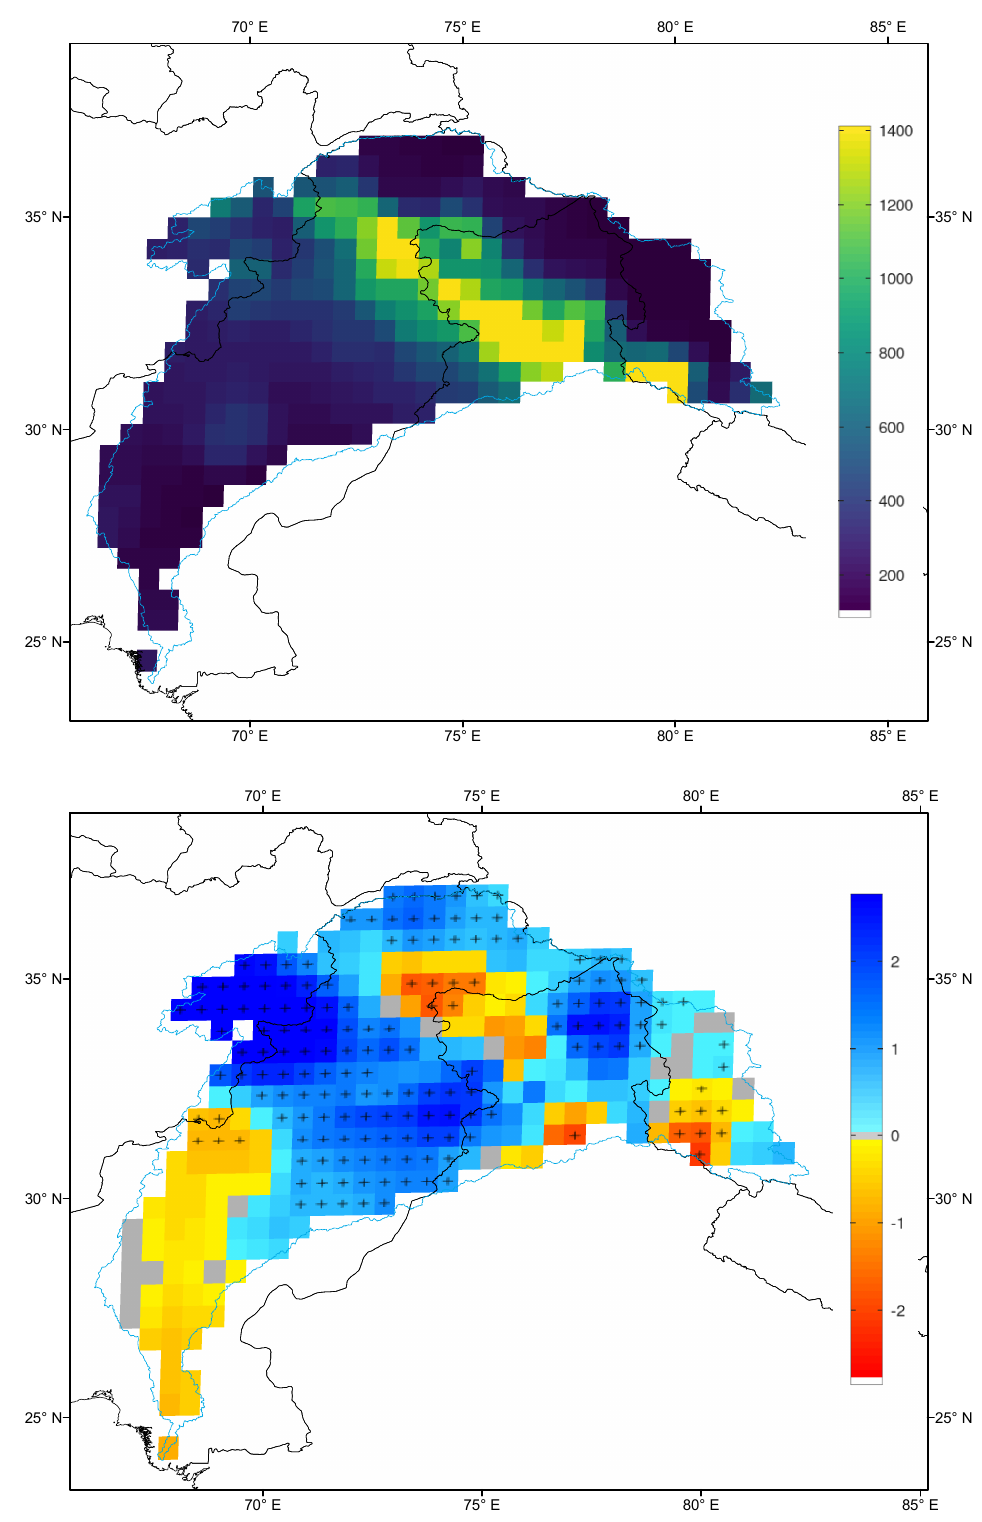
Figure 4. Top : mean precipitation (mm y − 1 ) over the Indus basin from GPCC, 1891–2016. Bottom : trend in precipitation (mm y − 2 ) by grid cell from GPCC, 1891–2016, with hatched areas indicating where the trend is statistically